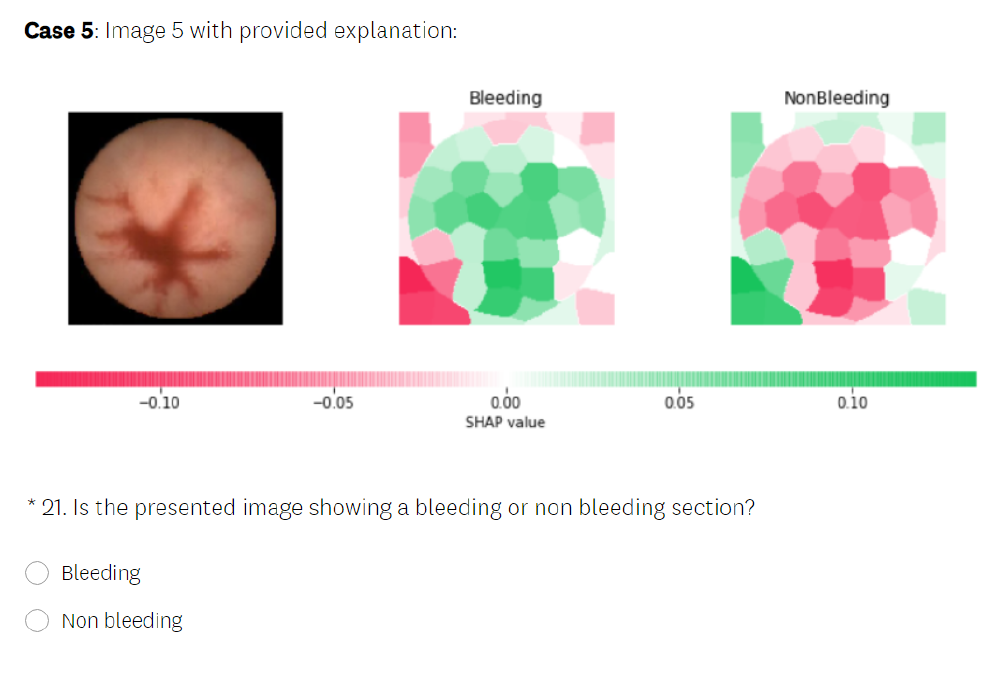
Figure 14. SHAP explanations in the user